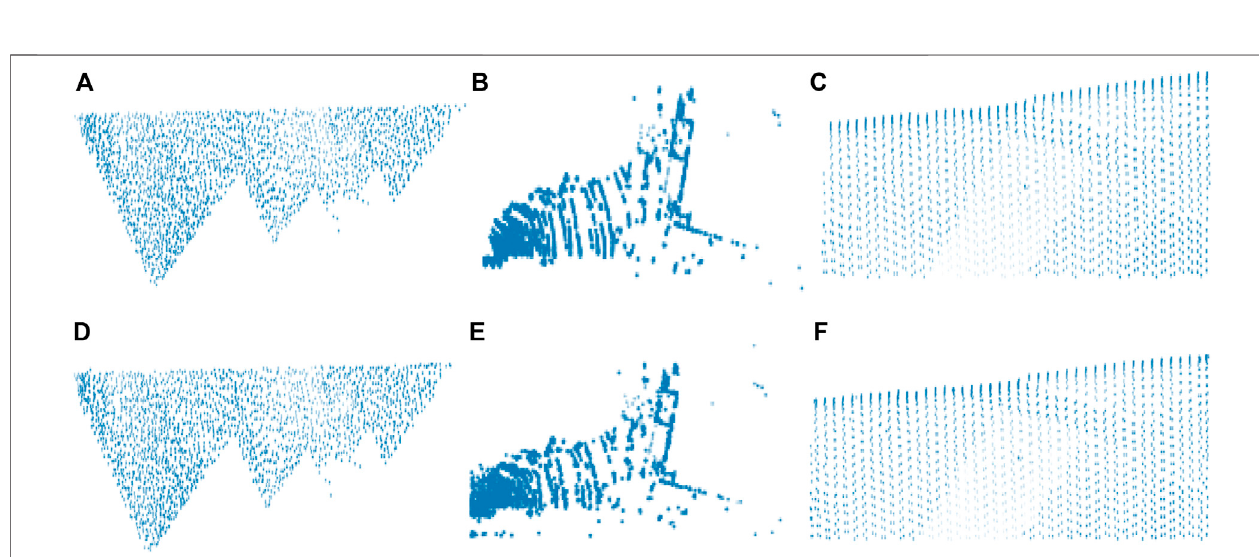
FIGURE6| TargetandtheactualresultpcdimagesoftheDLQmodel (A) TargetTest1(L) (B) TargetScan19761(S) (C) TargetFsite8(I) (D) ActualTest1(L) (E) Actual Scan19761(S) (F) Actual Fsite8(I).